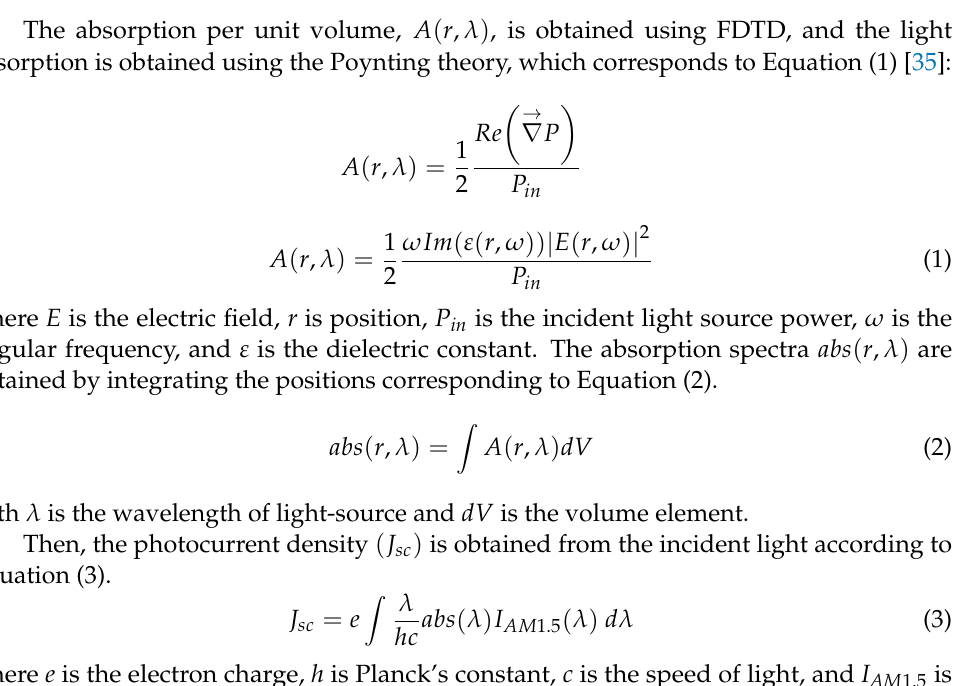
Table 1. Materials and size parameters for each layer of solar cells used in the simulation. Variations were made on the radius and lattice constant of the PC of TiO 2 nanodisk. Layer Material Size Transparent Electrode FTO (fluorine doped tin oxide) 80 nm thick Electron Transport (ETL) TiO 2 100 nm thick 100 nm thick, 37.5–225 nm Photonic Crystals TiO 2 radius, 450–1125 nm lattice constant Perovskite MAPbI 3 500 nm Hole Transport (HTL) Spiro-OMeTAD 300 nm Metal Electrode Au 80